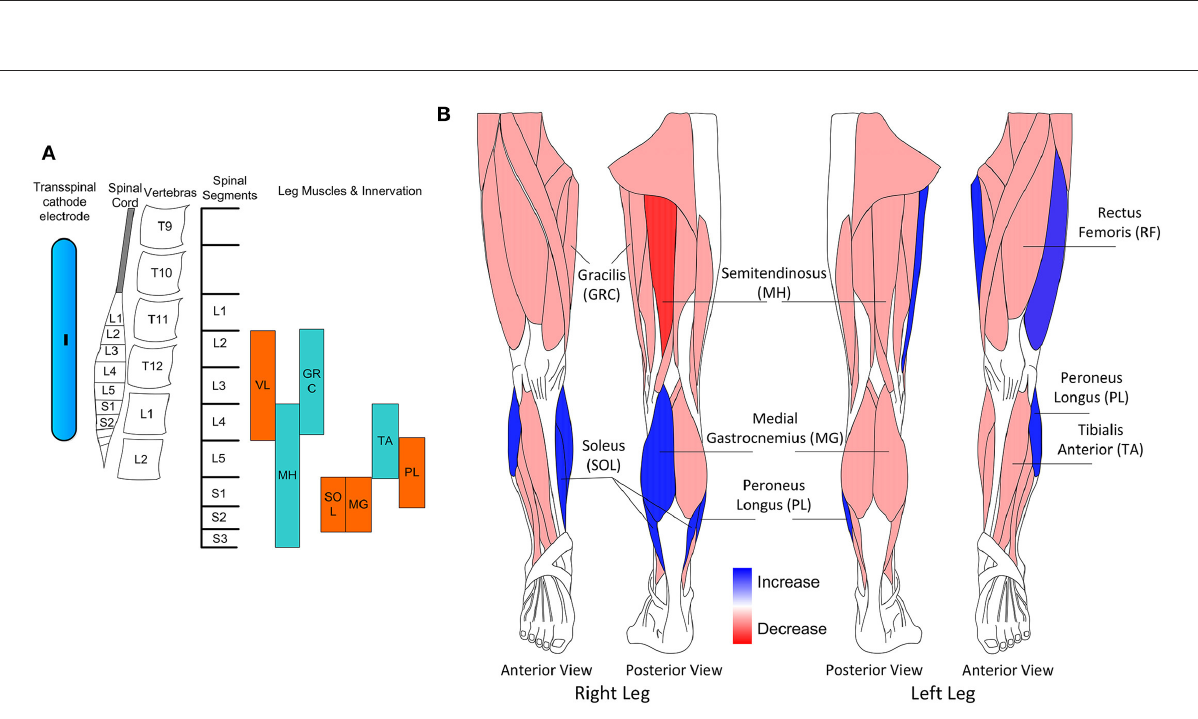
FIGURE5 (A) Schematic presentation of the transspinal cathodal electrode relative to the spinal cord, vertebras, spinal segments, and innervation of muscles from which transspinal evoked potentials (TEPs) were recorded in this study. (B) Schematic presentation of the muscles in which increase or decrease of motor output was observed for both